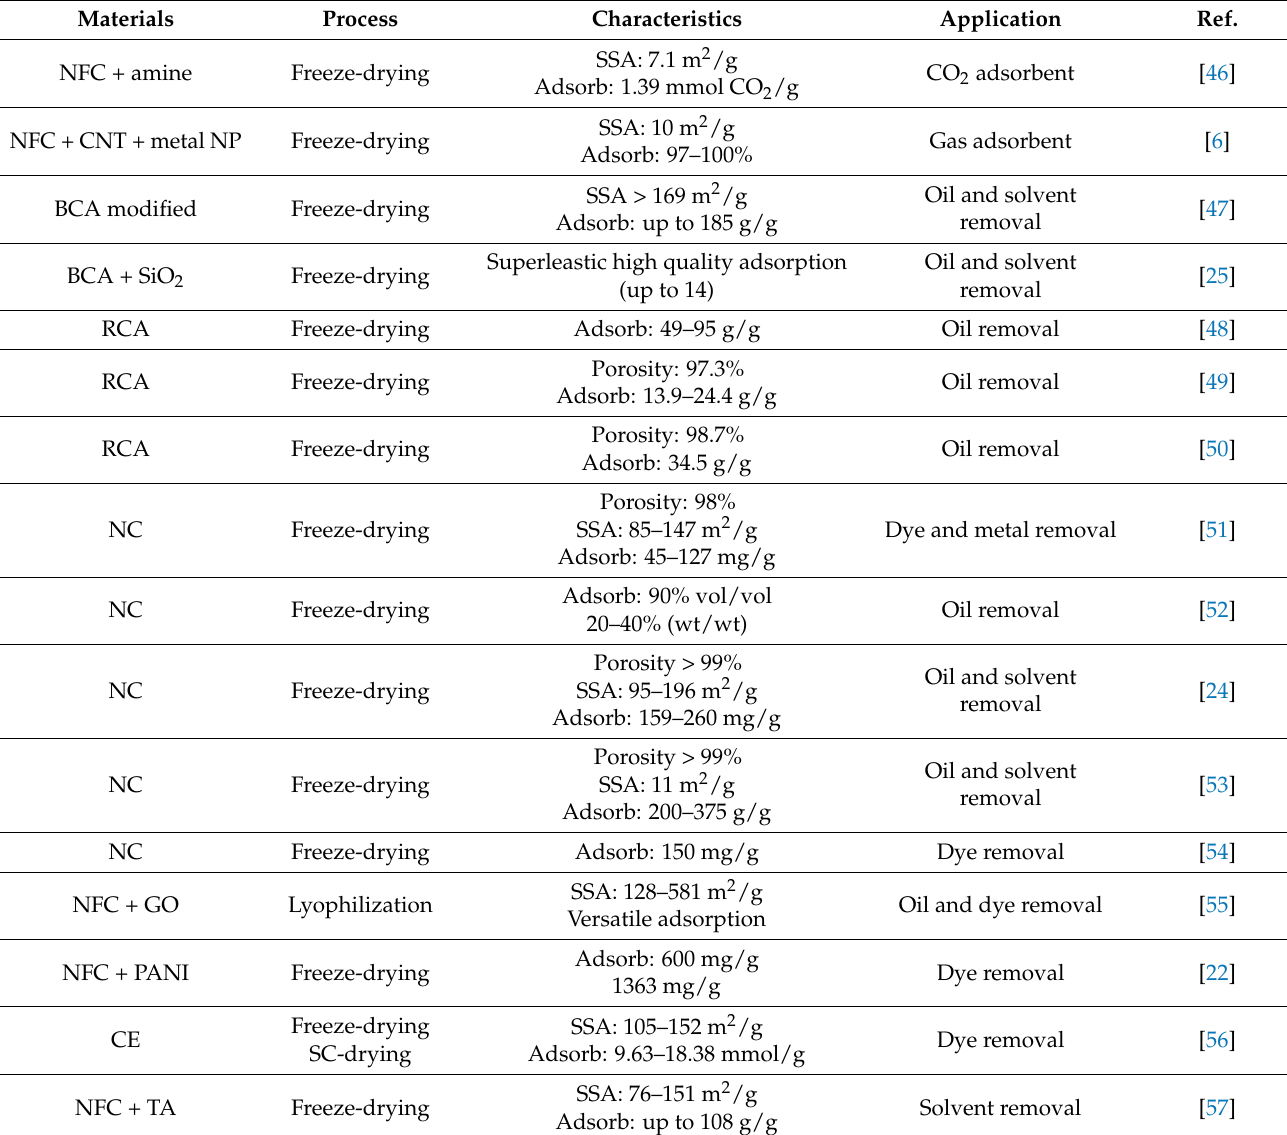
Table 1. Cellulose-based aerogels for the removal of pollutants. BCA: bacterial cellulose aerogels; NC: nanocellulose; CE: cellulose laurate ester; CNT: carbon nanotubes; NFC: nanofibrillated cellulose; NP: nanoparticles; PANI: polyaniline; RCA: recycled cellulose aerogel; SC: supercritical; SSA: specific surface area; TA: tannic